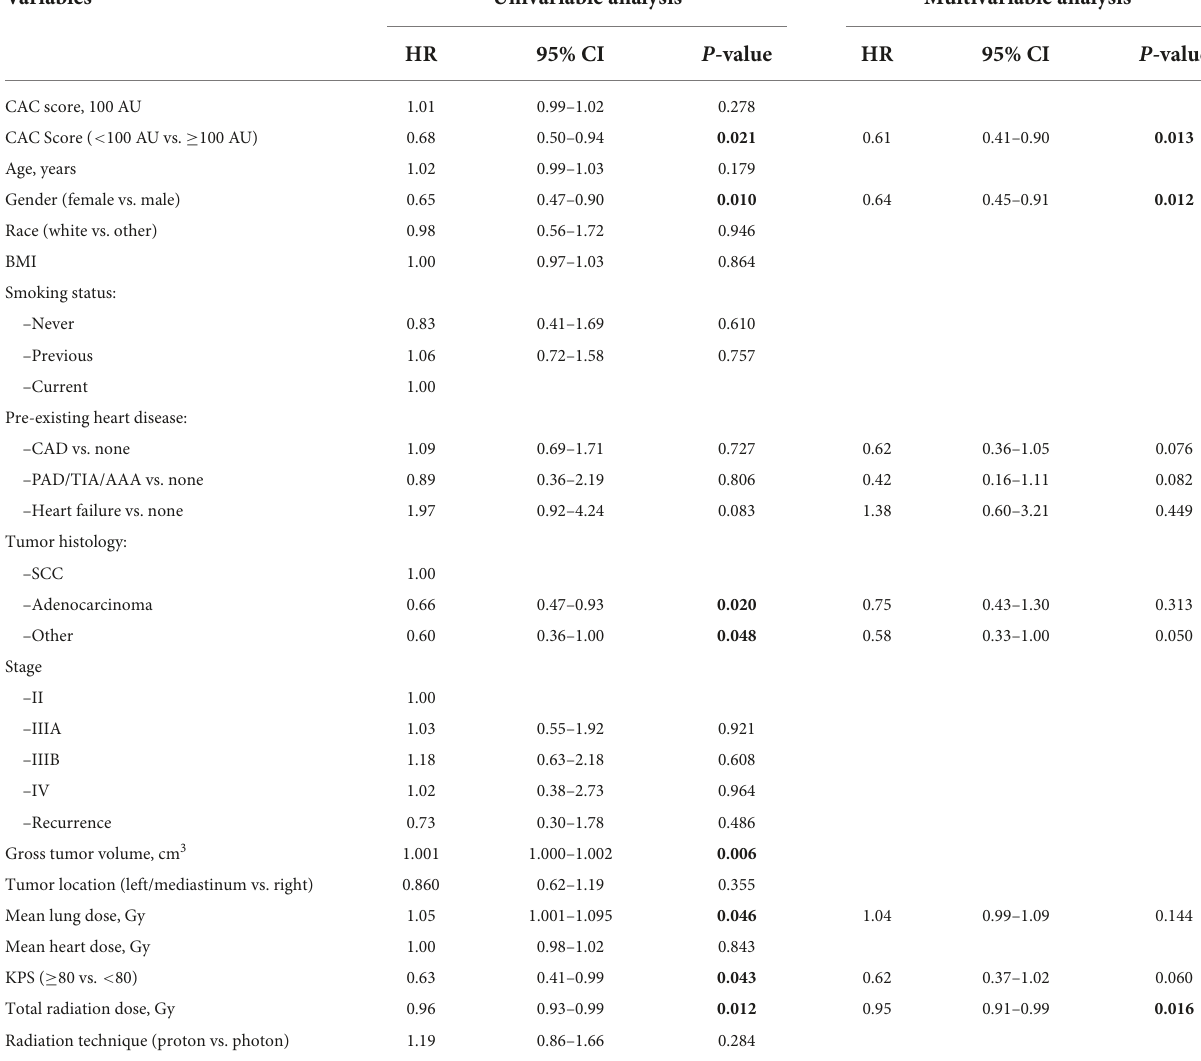
TABLE 3 Association of demographic and baseline clinical characteristics with overall survival based on univariable and multivariable Cox regression analysis.